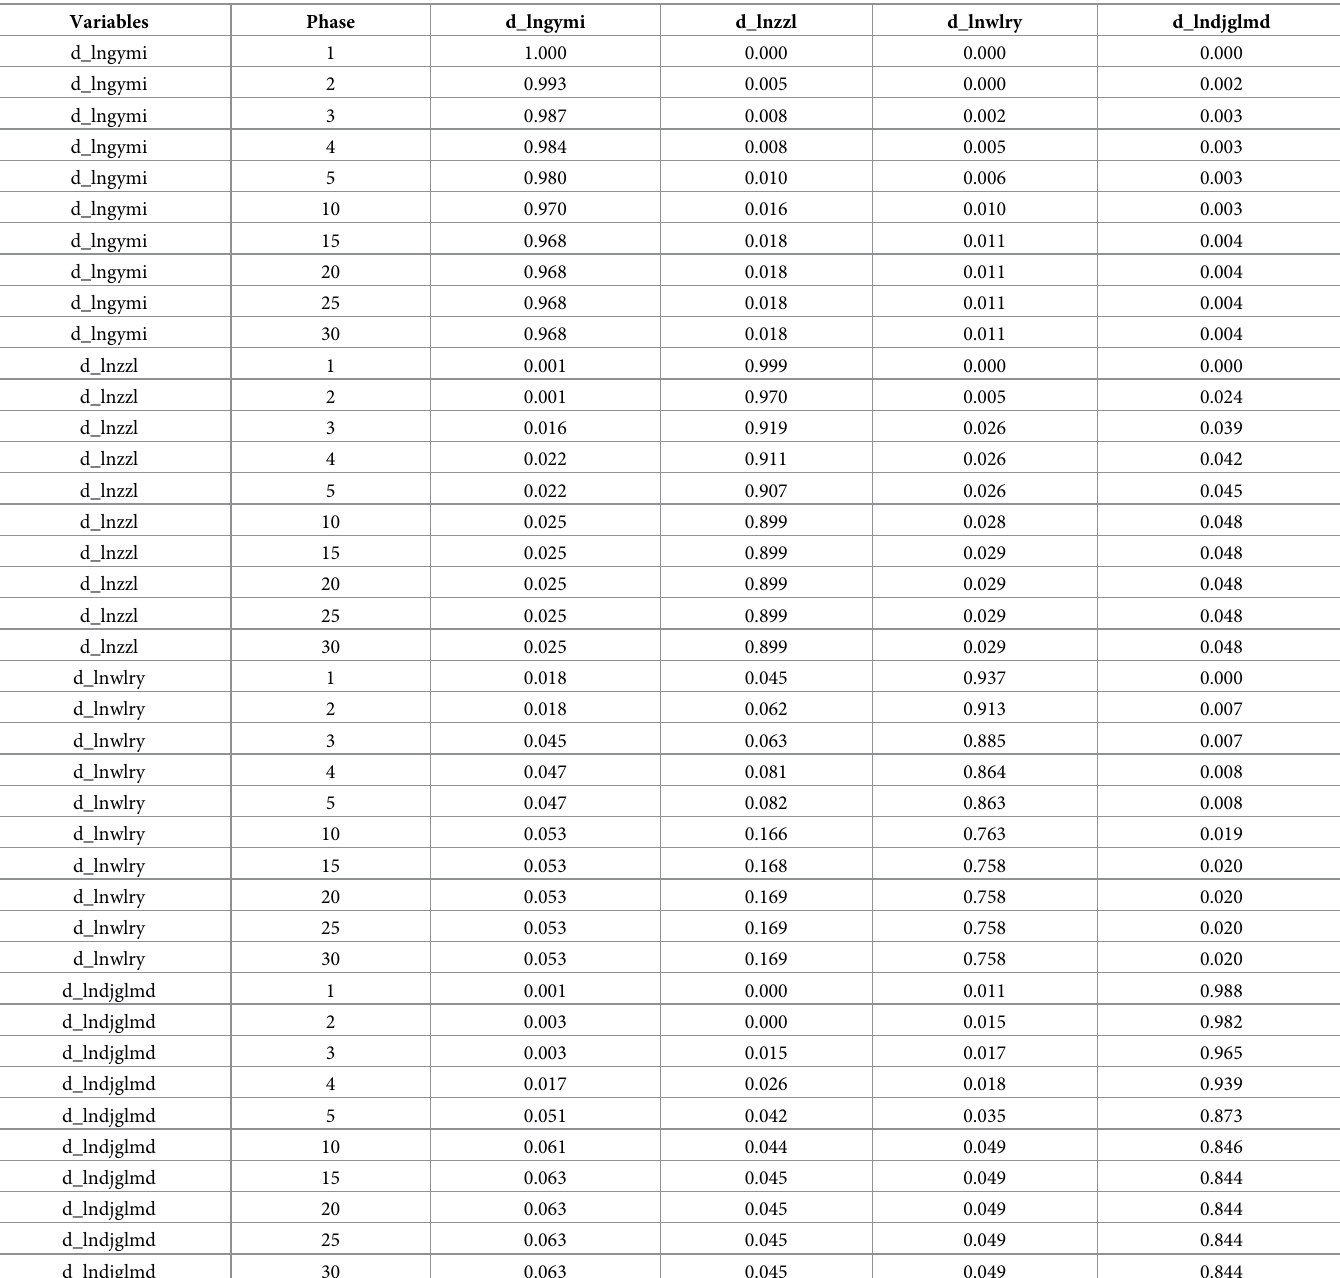
Table 17. Variance decomposition of logistics industry and manufacturing